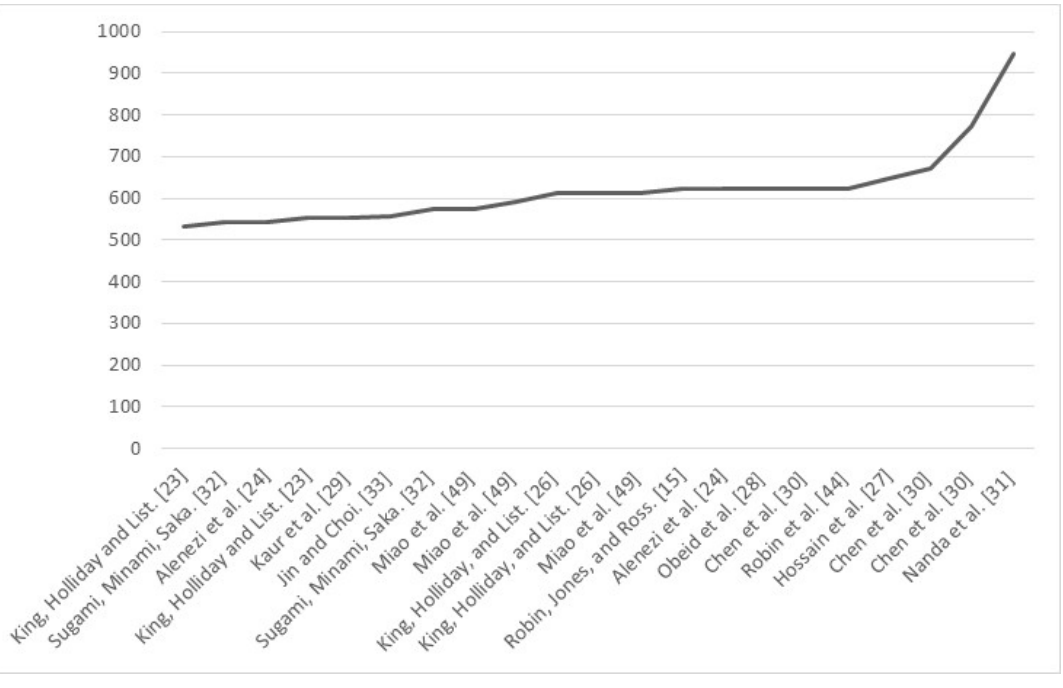
Figure 8. Temperatures (K) used in hydrothermal experiments with triglycerides.